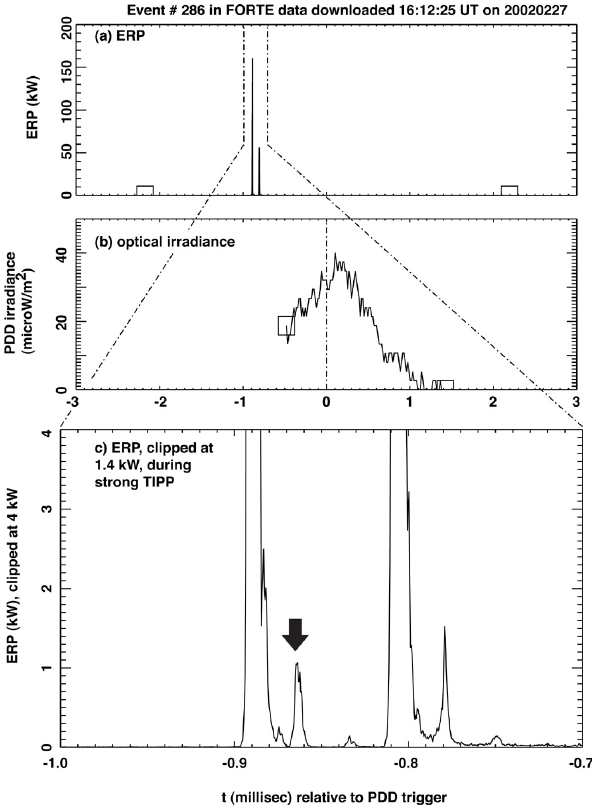
Fig. 6. Similar to Fig. 4, but for the fourth of the six HUMR–PDD events of Table 4. Arrow marks a “secondary-breakdown